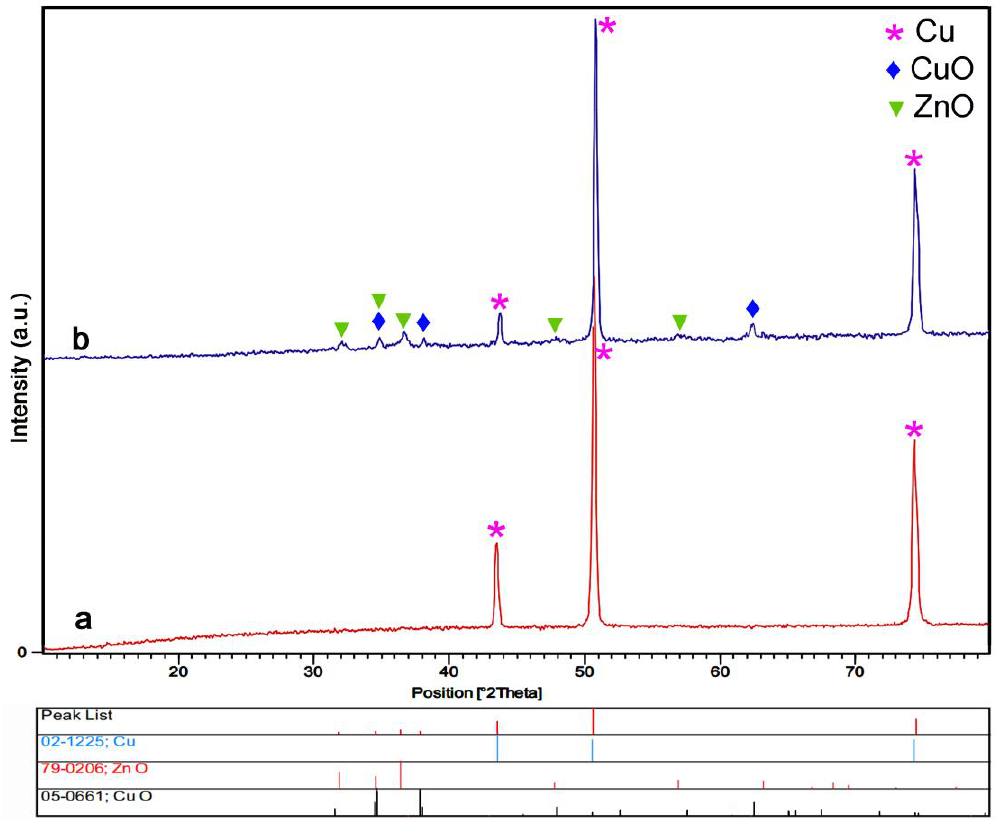
Figure 2. Wide-angle XRD patterns of the clean Cu foil obtained after cleaning treatment stage ( a ) and the as-prepared flower-like CuO-ZnO micro/nanostructures obtained after the engraving and glycothermal stages ( b ).